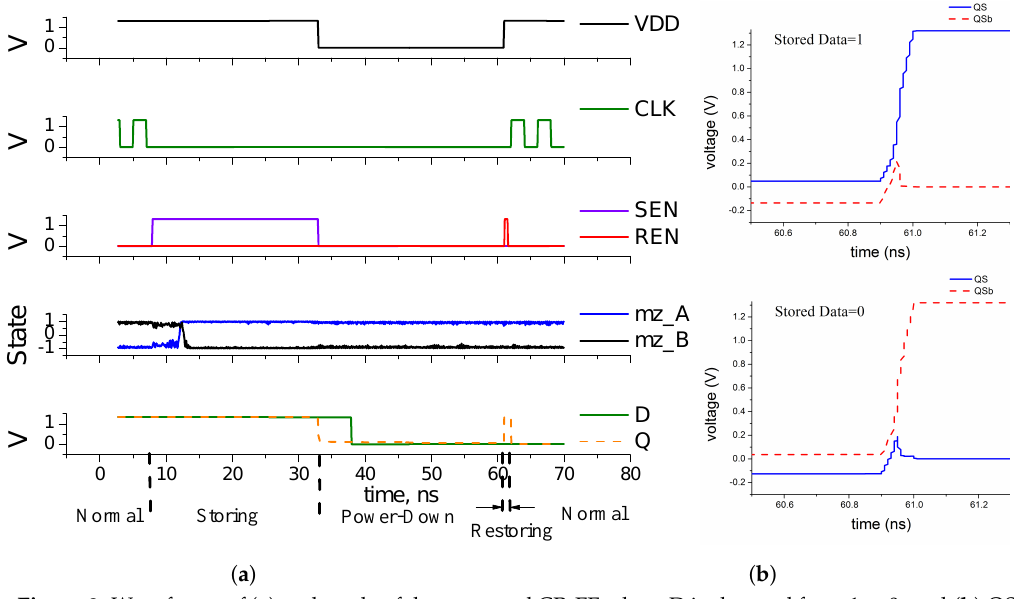
Figure 3. Waveforms of ( a ) each node of the proposed CR-FF where D is changed from 1 to 0, and ( b ) QS and QSb for enlarged views. Y-axes indicate voltage (V) of VDD, CLK, SEN, REN, D and Q nodes or states of MTJs (mz_A—MTJ A ’s spin direction on Z axis, mz_B—MTJ B ’s spin direction on Z